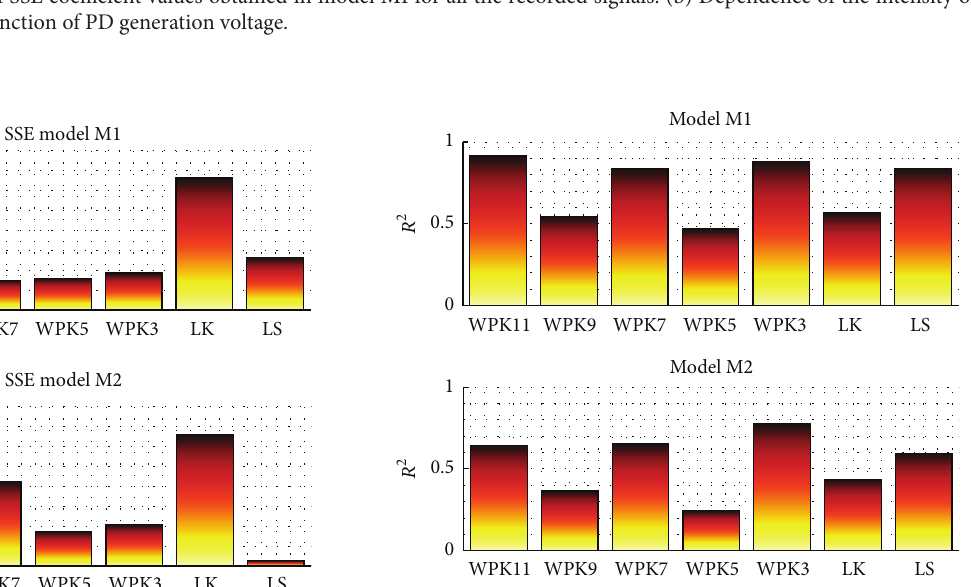
Figure 24: Comparison of the averaged values of the SSE coefficient obtained by the regression of models M1 and M2 for all the tested dielectrics and insulation systems.